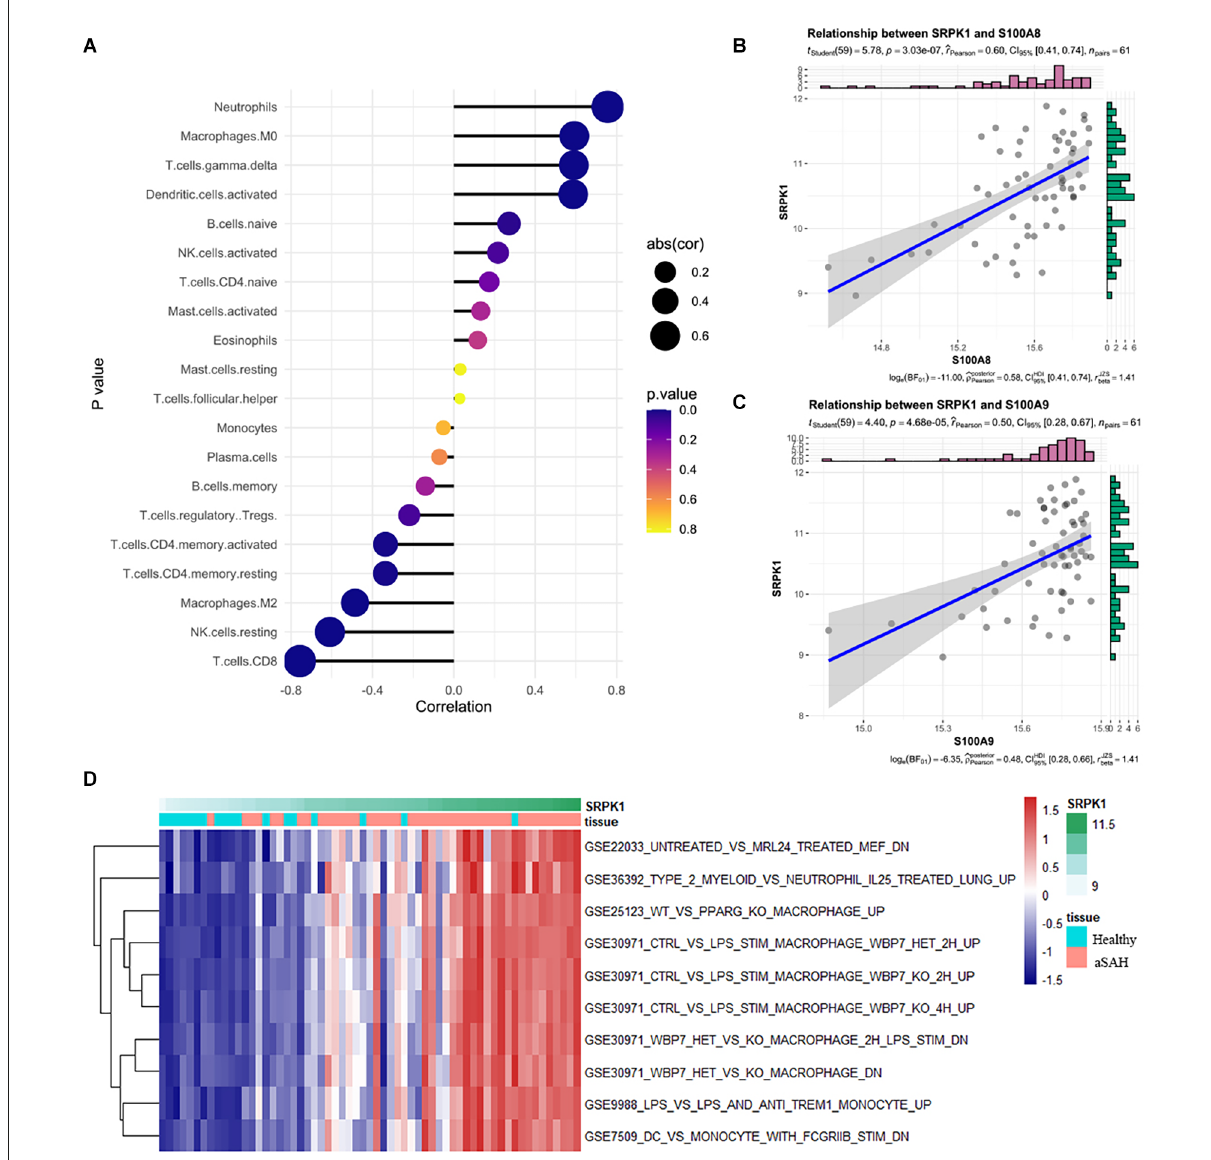
FIGURE5 (A) Relationships among infiltration levels of 22 immune cell types and SRPK1 expression profiles by Spearman’s analysis. (B,C) Correlation of marker gene of neutrophils S100A8 and S100A9 with SRPK1. The correlation coefficient was 0.60 ( p < 0.001) and 0.50 ( p < 0.001) respectively. (D) GSVA of significant immunologic signature pathways between aSAH and healthy samples along with SRPK1 expression in the blood sample